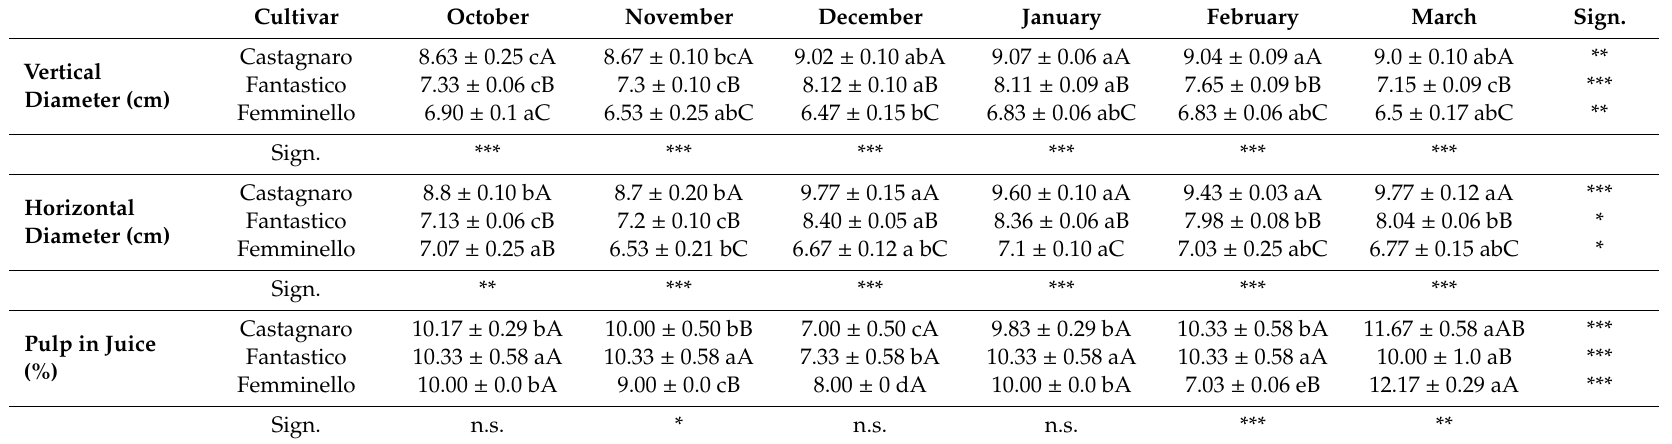
Table 1. Biometrics of bergamot fruit. Results are presented as the mean value ± standard deviation, n = 8, (2016–2017 and 2017–2018 harvest years).